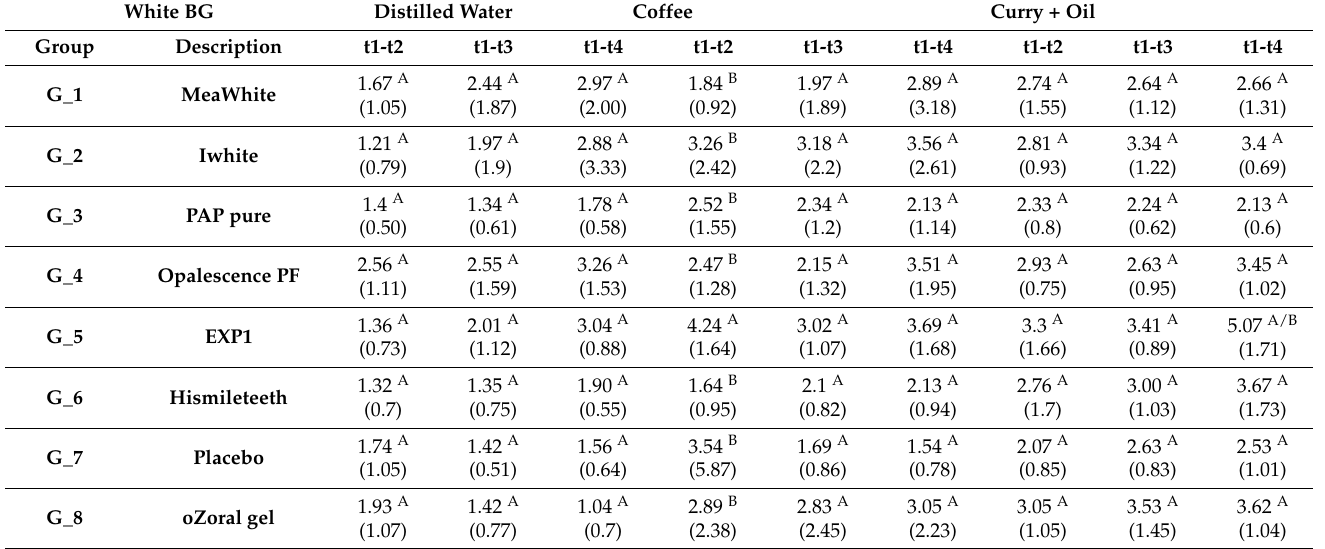
Table 4. Average CIEDE00 color changes over time and standard deviations (in parentheses) per group analyzed over a white background and corresponding grouping (A, best; D, worst). Results with the same capital letter are not significantly different according to Fisher’s LSD test; p value <